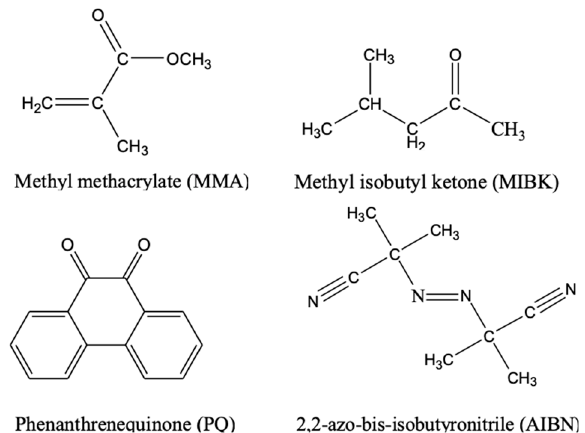
Figure 1. Chemical structures of the major components in the photopolymer sample.